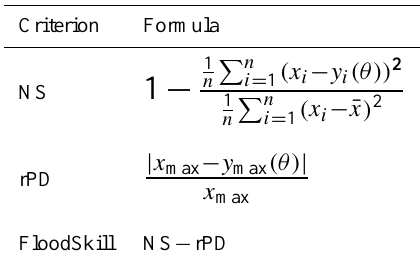
Table 4. Objective functions used in this study, where x i and y i (θ) are the observed and simulated discharge (by the parameter vector θ ) at time-step i respectively and n is the number of